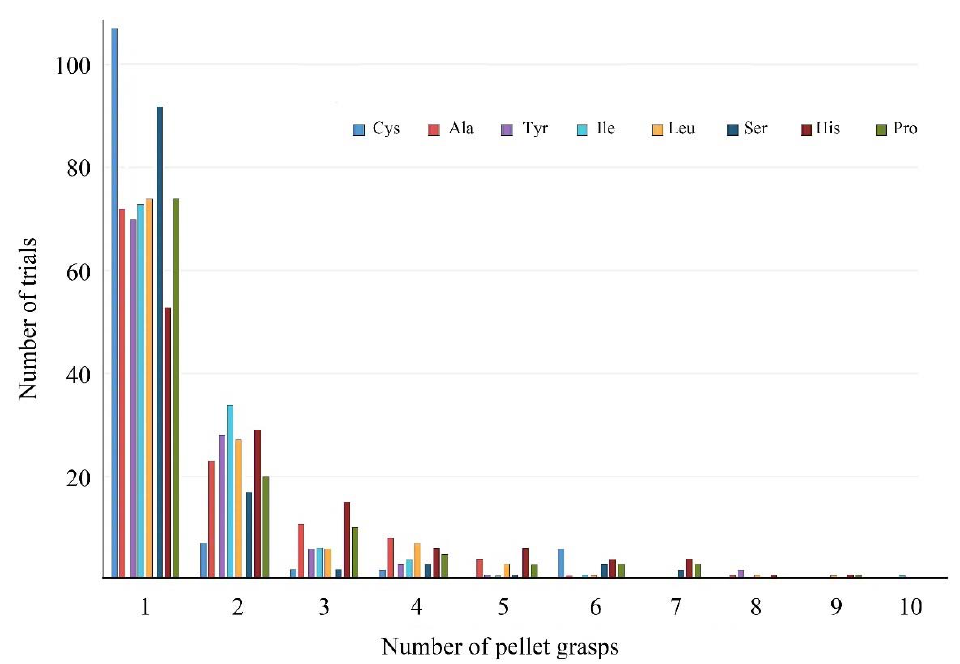
Figure 5. Frequency distribution of trials in relation to number of grasps per trial with pellets flavored with amino acids different by taste attractiveness for barramundi Lates calcarifer juveniles. Palatable amino acids: 1—cysteine (0.1 M) and 2—alanine (0.1 M); amino acids with indifferent taste: 3—serine (0.1 M), 4—histidine (0.1 M), and 5—proline (0.1 M); aversive amino acids: 7—tyrosine (0.001 M), isoleucine (0.01 M), and leucine (0.01 M).